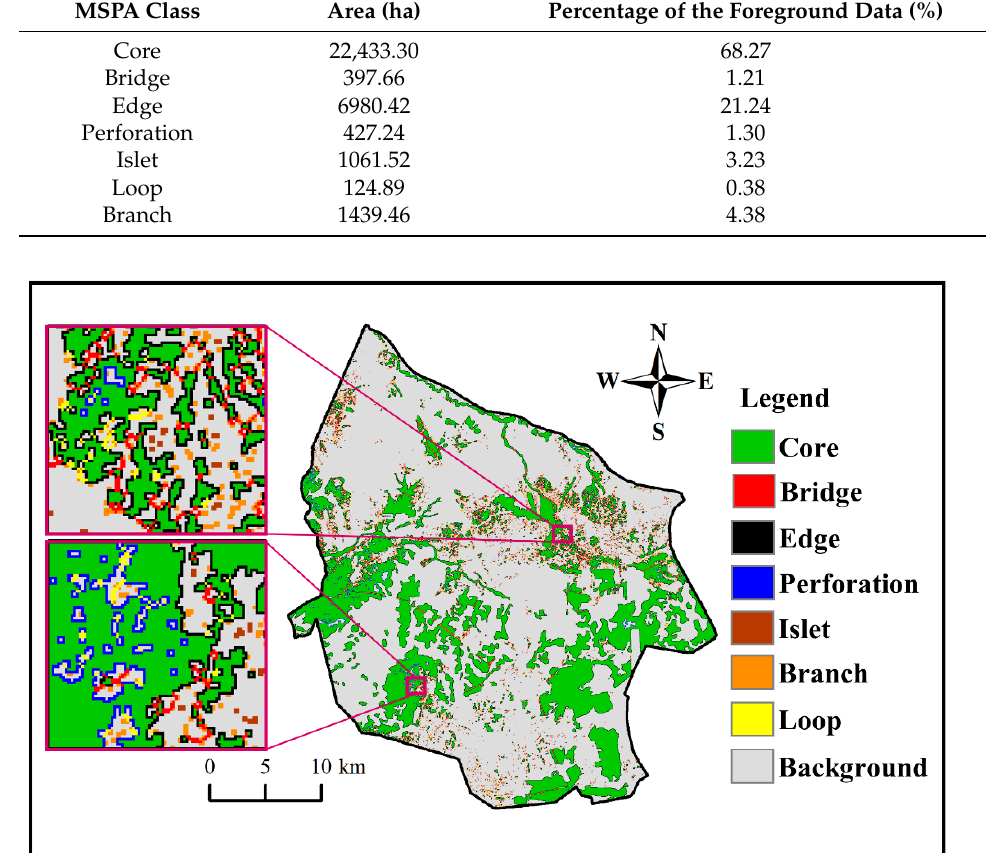
Figure 6. Distribution of landscape types based on MSPA. Table 5. Statistics of landscape type based on